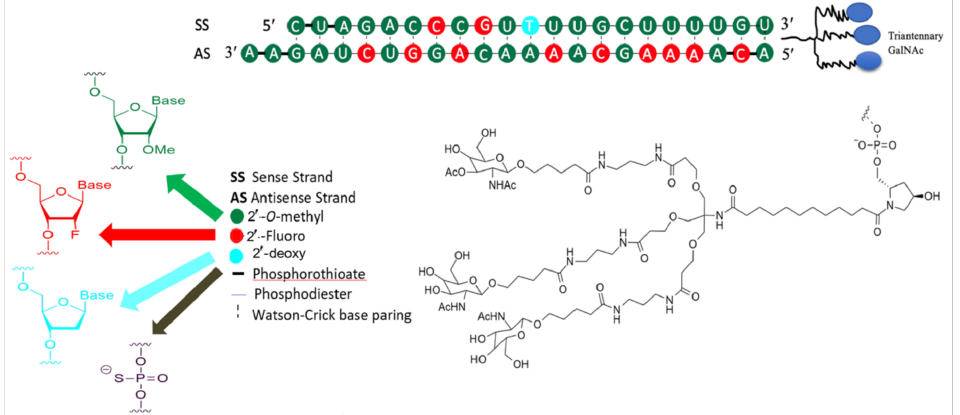
Figure 6. Chemical structure of